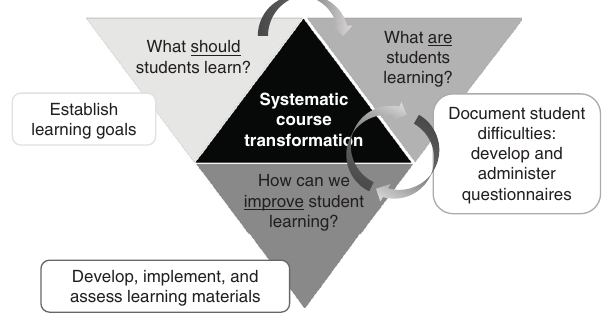
FIG. 1. A model of research-based course transformation. Adapted from Ref.